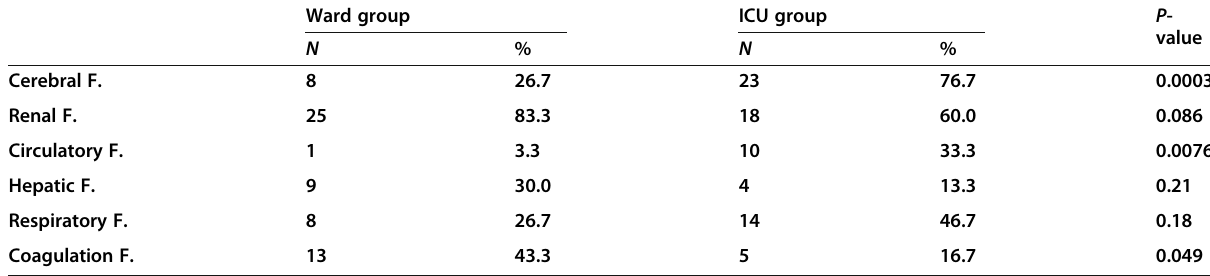
Table 1 Types of organ failure on admission in the studied groups Ward group ICU